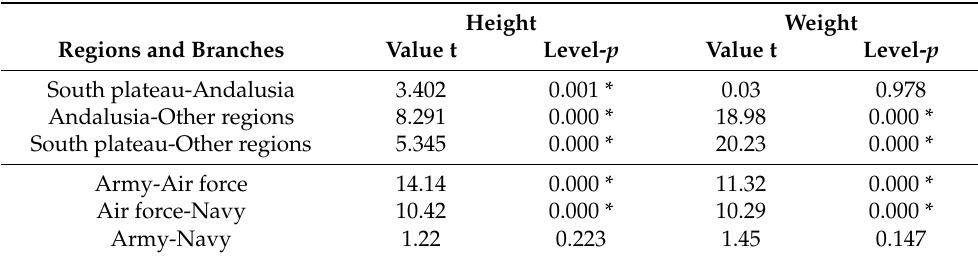
Table 6. Differences in anthropometric indicators by region and armed forces